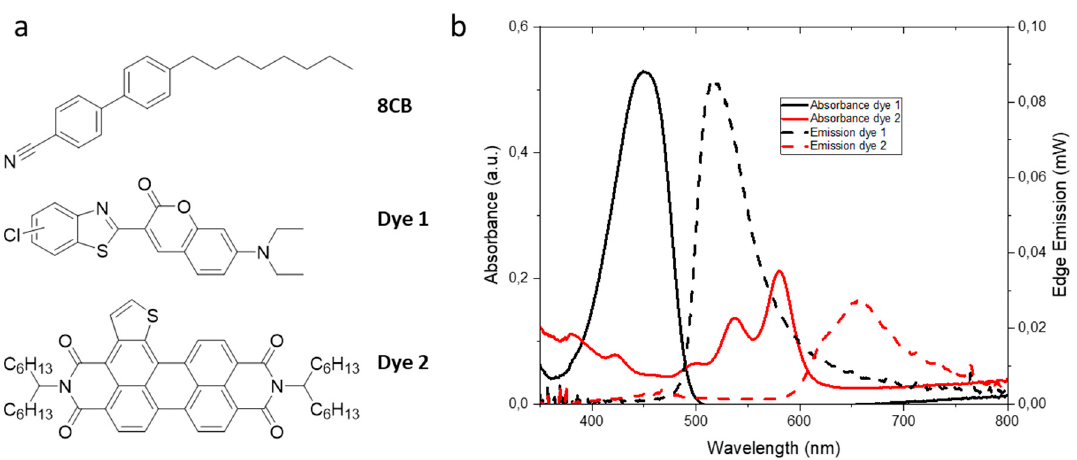
Figure 1. ( a ) The chemical structures of 8CB, Dye 1 and Dye 2. ( b ) Absorption (solid lines) and emission (from one edge parallel to the alignment direction, dotted lines) spectra of 1 wt% of Dye 1 Dye 2 (red) in 8CB in planar aligned 6 µ m gap (black) and Dye 2 (red) in 8CB in planar aligned 6 µm gap cells.